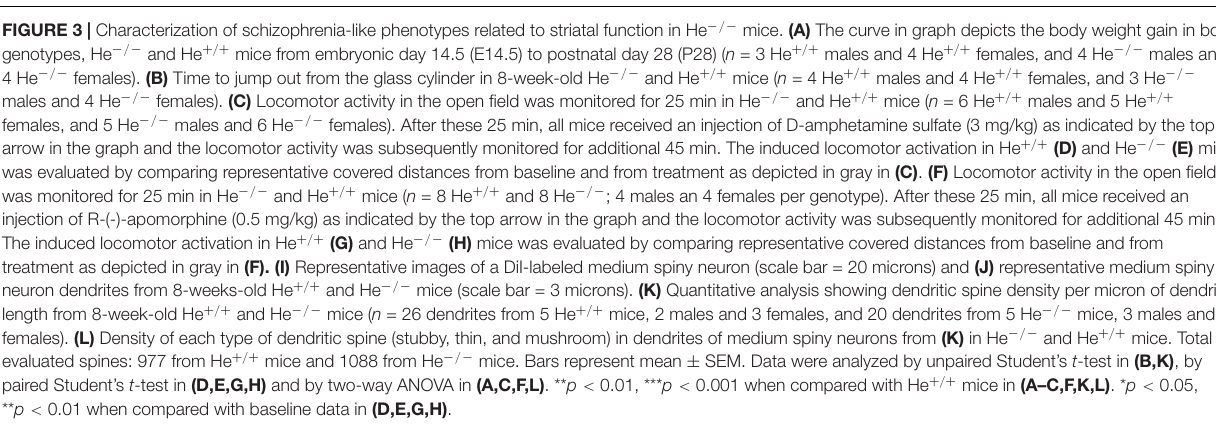
FIGURE 3 | Characterization of schizophrenia-like phenotypes related to striatal function in He − / − mice. (A) The curve in graph depicts the body weight gain in both genotypes, He − / − and He + / + mice from embryonic day 14.5 (E14.5) to postnatal day 28 (P28) ( n = 3 He + / + males and 4 He + / + females, and 4 He − / − males and 4 He − / − females). (B) Time to jump out from the glass cylinder in 8-week-old He − / − and He + / + mice ( n = 4 He + / + males and 4 He + / + females, and 3 He − / − males and 4 He − / − females). (C) Locomotor activity in the open field was monitored for 25 min in He − / − and He + / + mice ( n = 6 He + / + males and 5 He + / + females, and 5 He − / − males and 6 He − / − females). After these 25 min, all mice received an injection of D-amphetamine sulfate (3 mg/kg) as indicated by the top arrow in the graph and the locomotor activity was subsequently monitored for additional 45 min. The induced locomotor activation in He + / + (D) and He − / − (E) mice was evaluated by comparing representative covered distances from baseline and from treatment as depicted in gray in (C) . (F) Locomotor activity in the open field was monitored for 25 min in He − / − and He + / + mice ( n = 8 He + / + and 8 He − / − ; 4 males an 4 females per genotype). After these 25 min, all mice received an injection of R-(-)-apomorphine (0.5 mg/kg) as indicated by the top arrow in the graph and the locomotor activity was subsequently monitored for additional 45 min. The induced locomotor activation in He + / + (G) and He − / − (H) mice was evaluated by comparing representative covered distances from baseline and from treatment as depicted in gray in (F). (I) Representative images of a DiI-labeled medium spiny neuron (scale bar = 20 microns) and (J) representative medium spiny neuron dendrites from 8-weeks-old He + / + and He − / − mice (scale bar = 3 microns). (K) Quantitative analysis showing dendritic spine density per micron of dendritic length from 8-week-old He + / + and He − / − mice ( n = 26 dendrites from 5 He + / + mice, 2 males and 3 females, and 20 dendrites from 5 He − / − mice, 3 males and 2 females). (L) Density of each type of dendritic spine (stubby, thin, and mushroom) in dendrites of medium spiny neurons from (K) in He − / − and He + / + mice. Total evaluated spines: 977 from He + / + mice and 1088 from He − / − mice. Bars represent mean ± SEM. Data were analyzed by unpaired Student’s t -test in (B,K) ,